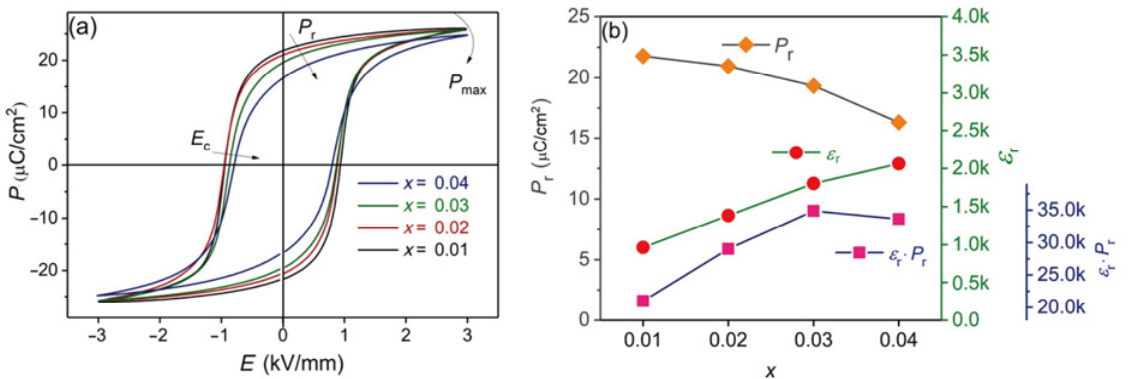
Fig. 5 (a) Typical P  E loops of LKNNS  EuNZ  x BZ samples; (b) summarized results of P r , ε r , and ε r P r of LKNNS  EuNZ  x BZ